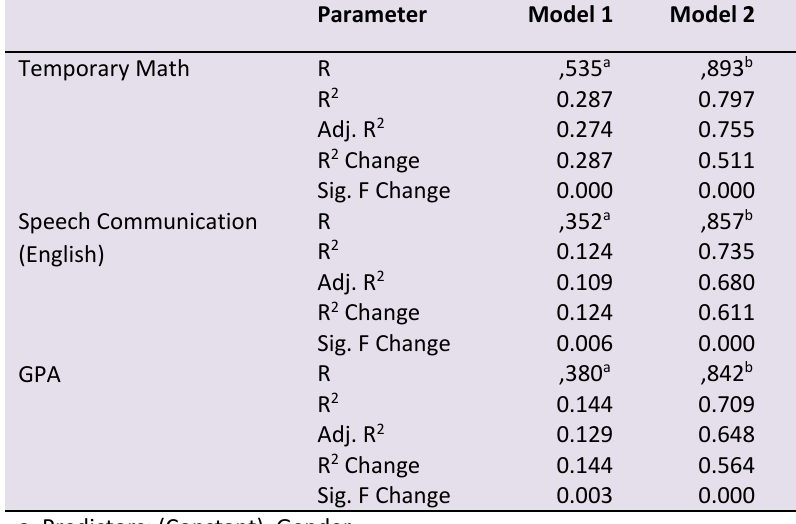
Table 6. Model summary of hierarchical regression